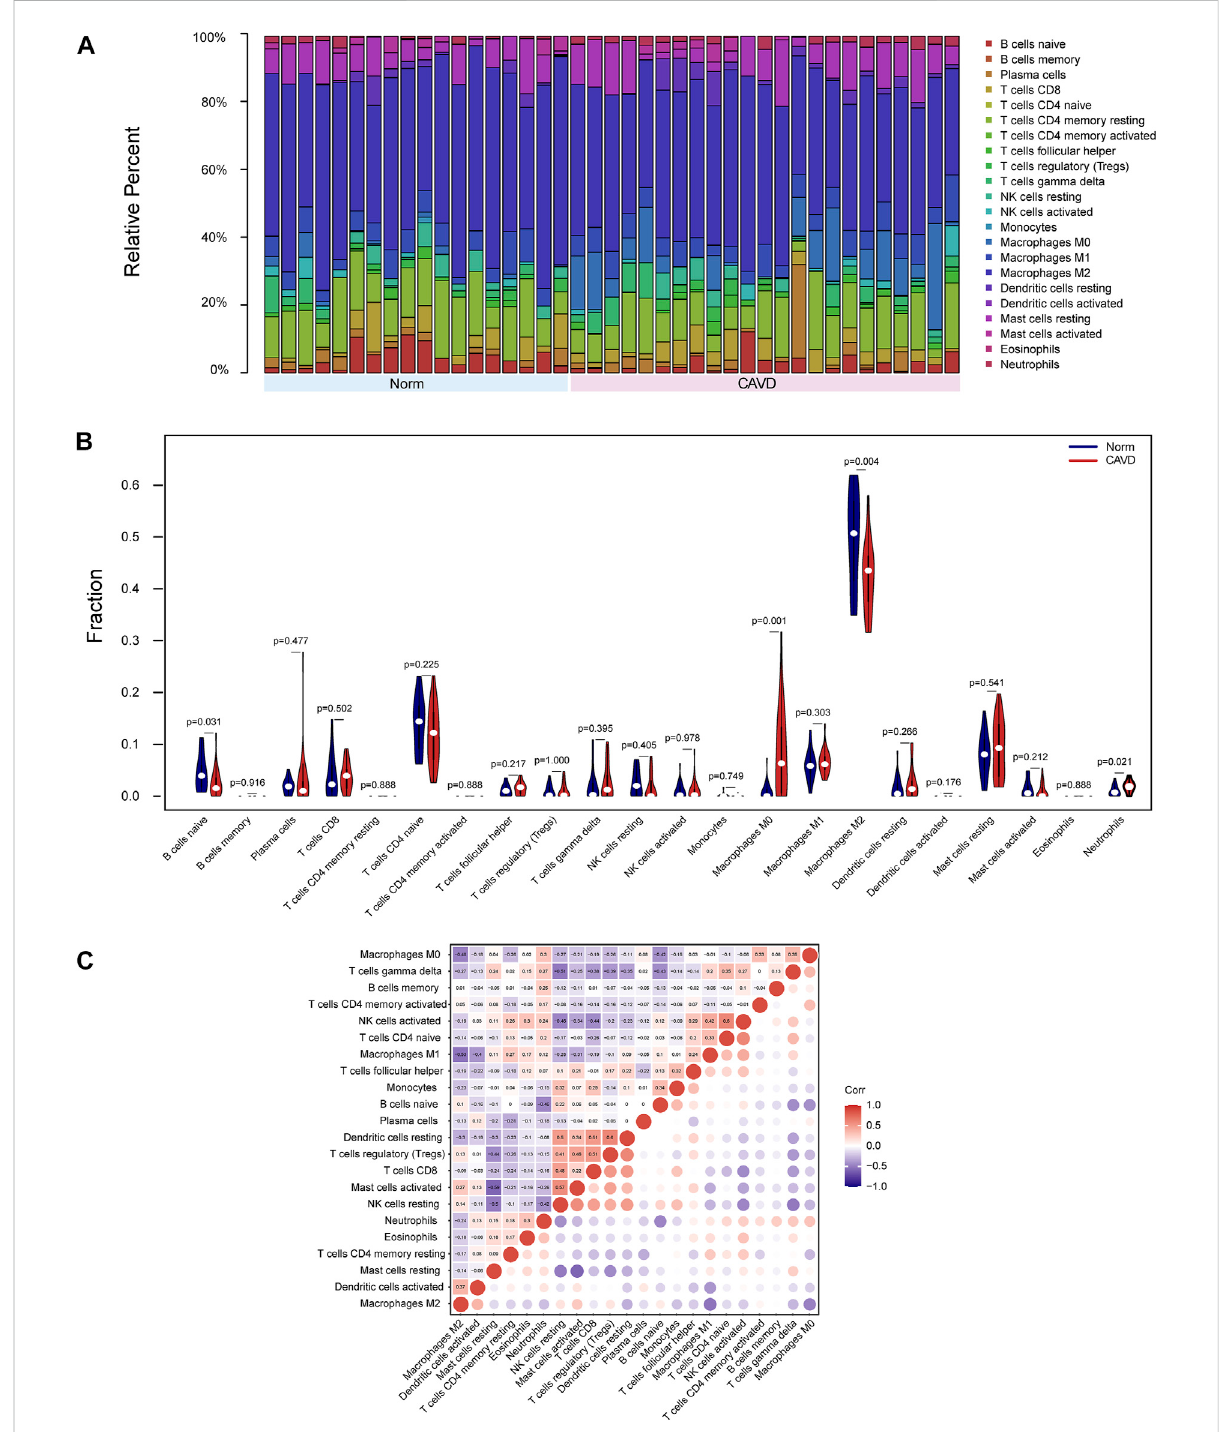
FIGURE 6 Landscape of immune cell in fi ltration of calci fi c aortic valve disease (CAVD). (A) Barplot of the proportions of 22 immune cell subpopulations in each group. The samples clustered in light blue are normal aortic valve group, and the samples clustered in light red are CAVD group. (B) Violin plot showing differentially in fi ltrated immune cells between normal (blue) and CAVD (red) groups. The vertical axis represents the relative proportion of immune cells. (C) Correlation matrix of 22 immune cell subtype compositions. Numbers in the small square represent Pearson ’ s correlation coef fi cient between the two immune cells in the horizontal and vertical coordinates. The color shades of the squares represent the degree of